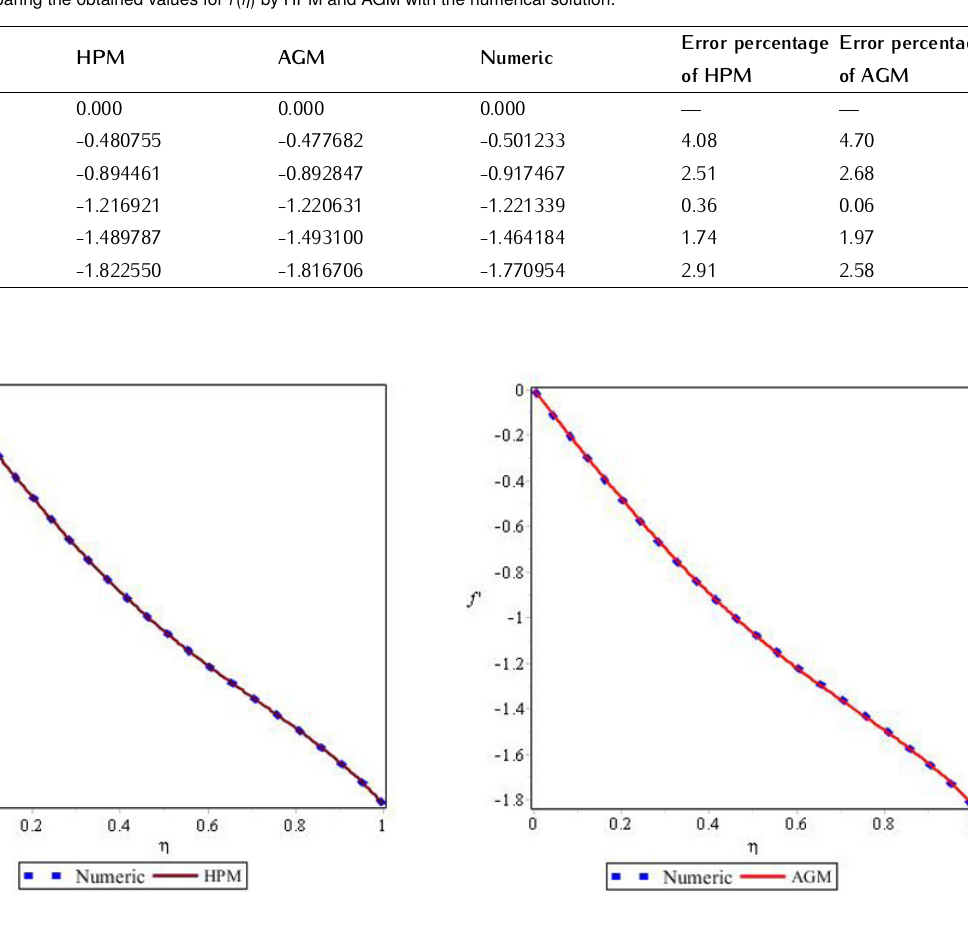
Figure 4. A comparison between the achieved solutions for f 0 HPM and numerical method.